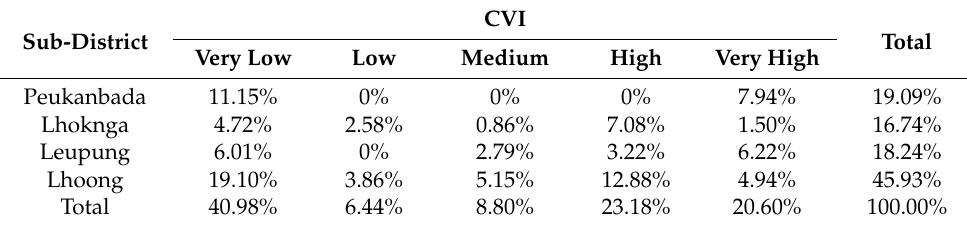
Table 8. West Aceh Besar coastal vulnerability index percentages .